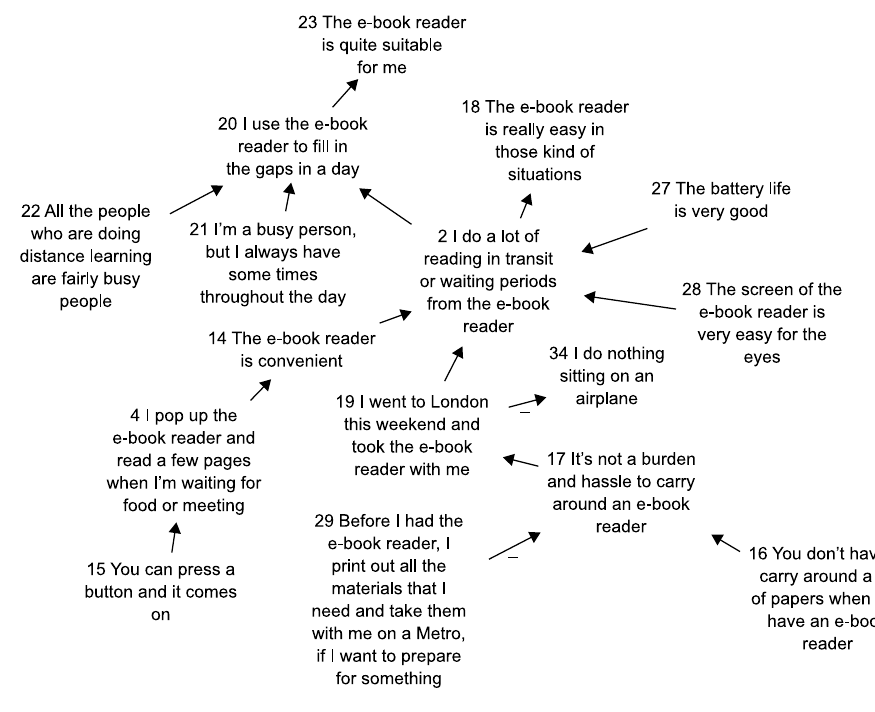
Figure 3. Effective use of time.